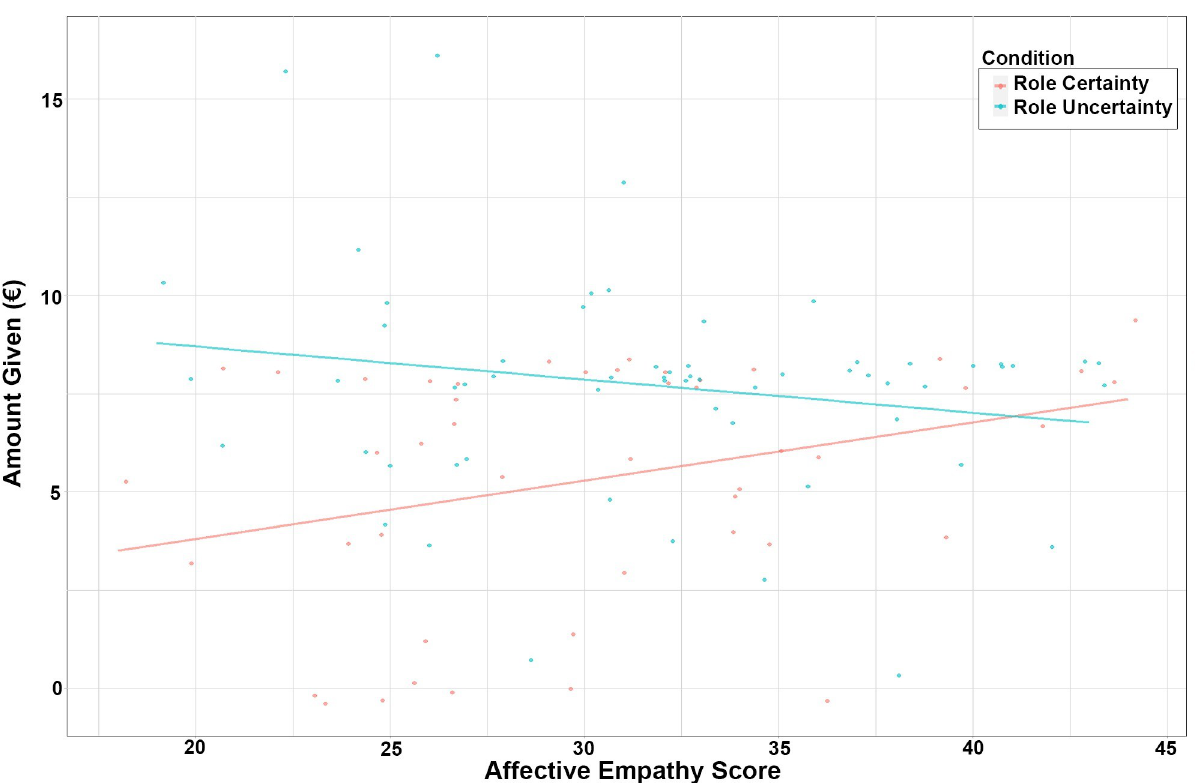
Fig 3. Dictator game giving predicted by the affective empathy score (cyan line: Role uncertainty, red line: Role certainty).